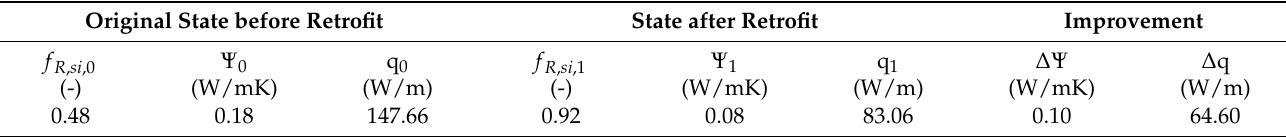
Quantifiable results of the thermal bridge retrofit of a window sill (ThermCad thermal bridge simulation